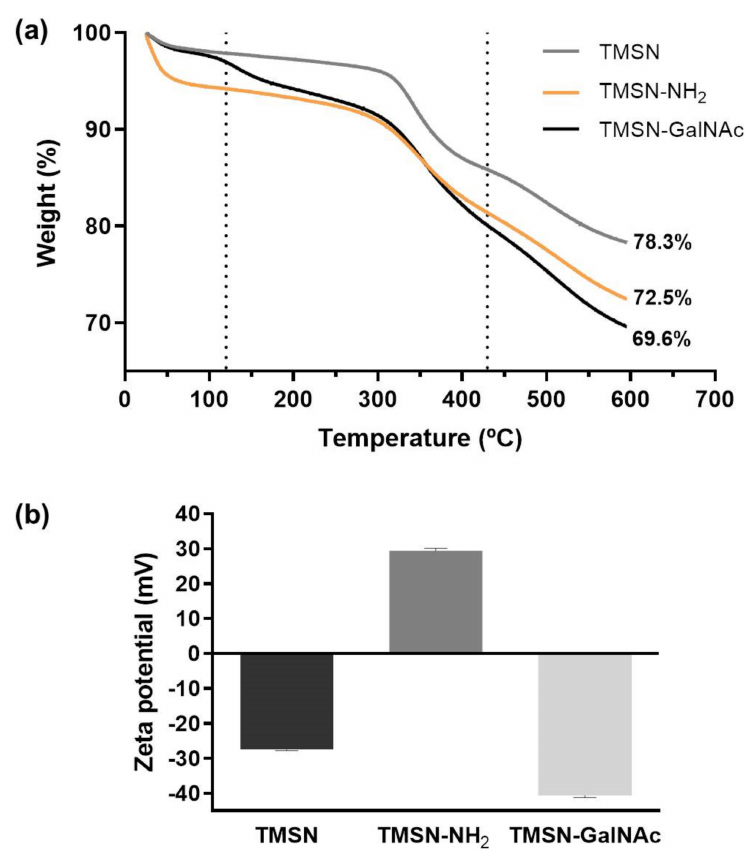
Figure 4. Thermograms ( a ) and zeta potential ( b ) of TMSN, TMSN-NH 2 , and TMSN-GalNAc.